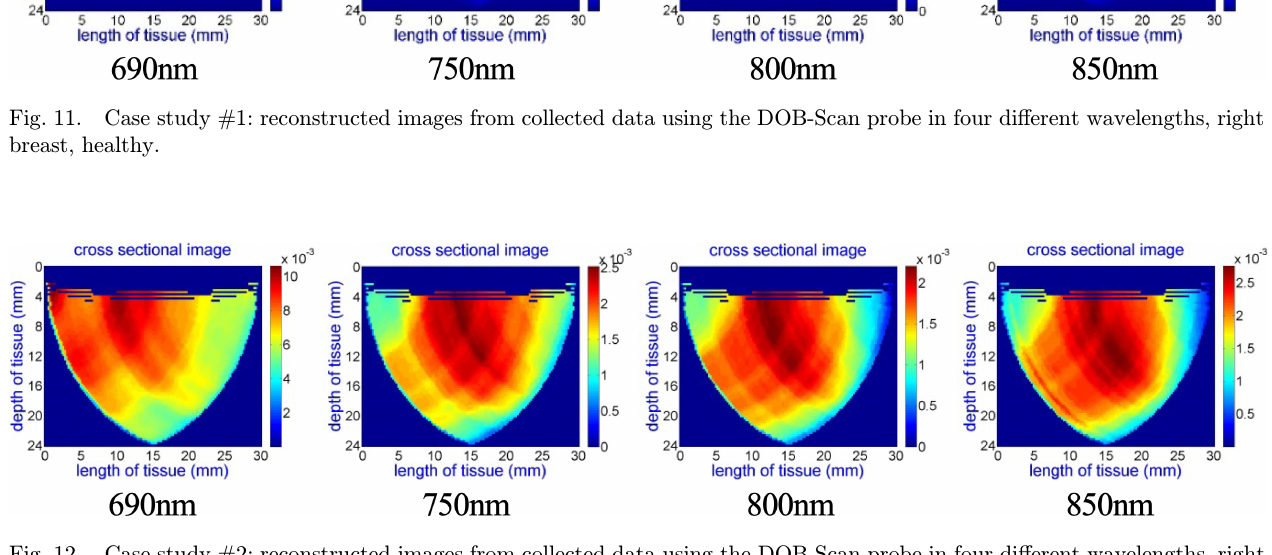
Fig. 12. Case study #2: reconstructed images from collected data using the DOB-Scan probe in four di®erent wavelengths, right breast and cancerous lesion located 1.8 cm from nipple at 1 o'clock position.